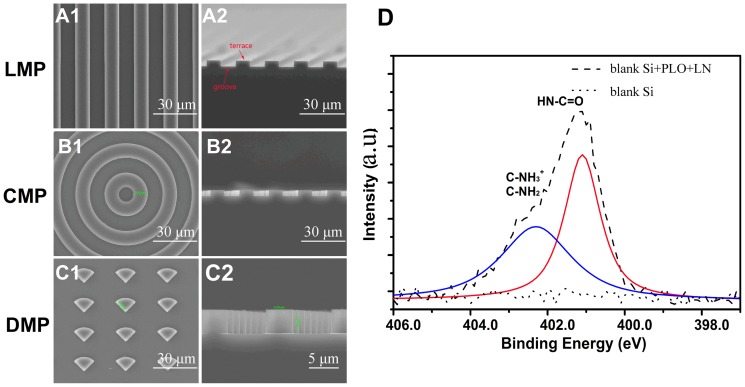
Representative SEM images of LMP (A1), CMP (B1), DMP (C1) substrates and their corresponding cross-section images (A2, B2, C2).(D) High-resolution XPS spectra of blank silicon substrates before (dot) and after (dash) PLO-LN coating. Scale bar  = 30 µm (A1–C1) and 5 µm (C2).